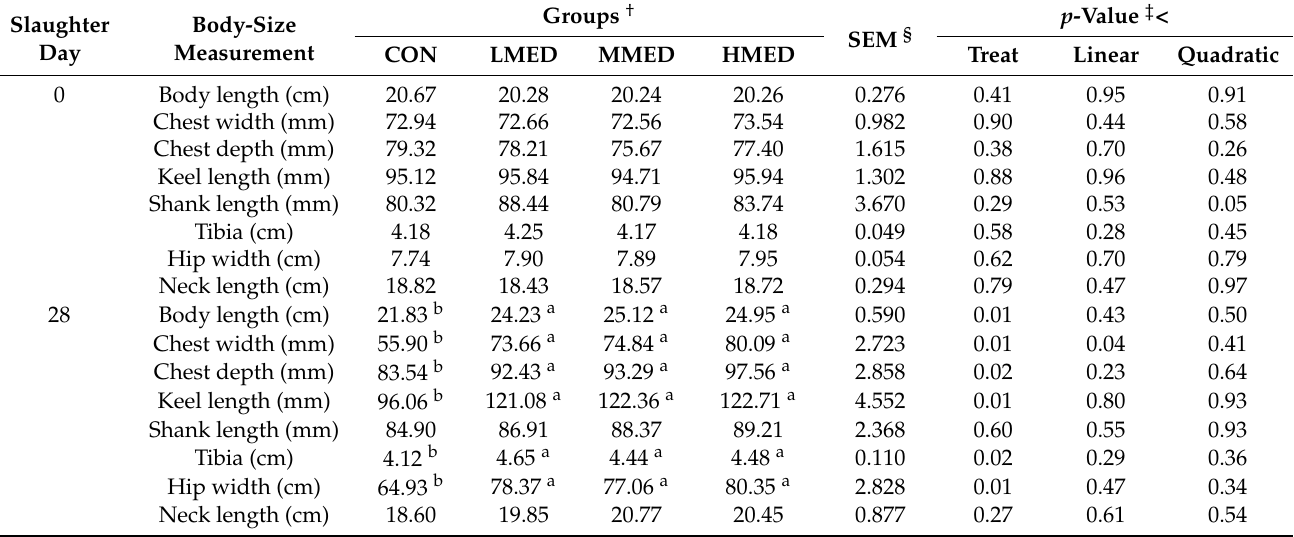
Table 3. Effects of supplemental feeding diets with three levels of metabolizable energy (ME) on body-size measurements of grazing Swan